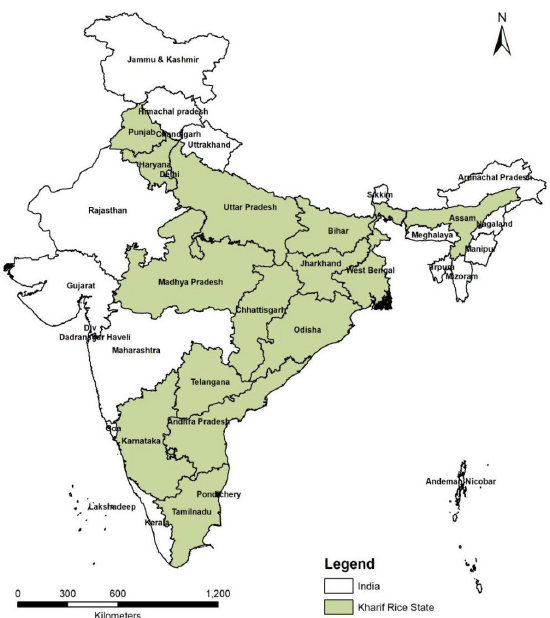
Figure 1. Study area map, showing the states for which kharif rice acreage estimation is carried out.